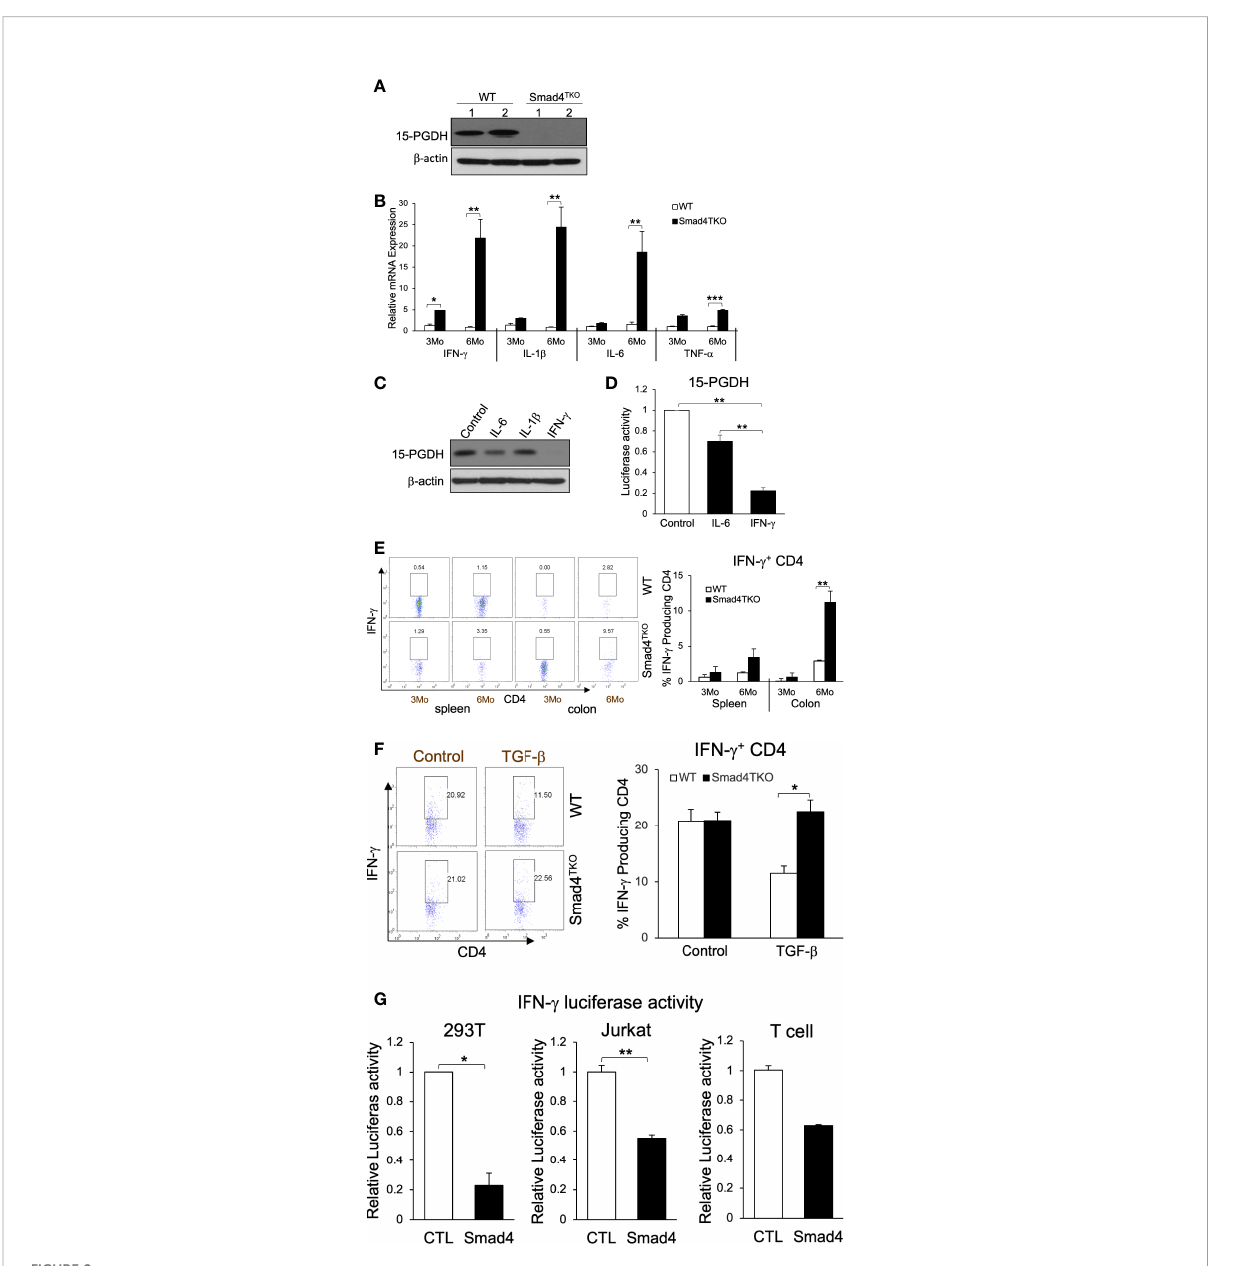
FIGURE 2 IFN- g down-regulates 15-PGDH expression in colon carcinoma cells and is inhibited by Smad4-dependent TGF- b signaling in T cells. (A) Protein expression of 15-PGDH was examined in the colon of WT and Smad4 TKO mice at 6 months of age by Western blot analysis. (B) Relative mRNA expression of pro-in fl ammatory cytokines (IFN- g , IL-1 b , IL-6 and TNF- a ) were measured by real time PCR in colon mucosa of WT and Smad4 TKO at 3 months and 6 months of age (n=4-6). (C) The effects of pro-in fl ammatory cytokines on 15-PGDH protein expressions in FET colon carcinoma cells. FET cells were treated with pro-in fl ammatory cytokines including IL-6 (20ng/ml), IL-1 b (5ng/ml) and IFN- g (20ng/ml) for 24 hrs and harvested for Western blot analysis to determine effects of these in fl ammatory cytokines on 15-PGDH protein expression. (D) 15- PGDH promoter activity in FET cells stimulated with IFN- g (20ng/ml) or IL-6 (20ng/ml) for 24 hrs was measured by using a dual luciferase assay. IFN- g suppressed 15-PGDH promoter luciferase activity. Results are representative of three different experiments. Bars, S.E. n=4, ** p < 0.01 compared with vehicle control group. (E) Analysis of effector CD4 + T cells expressing IFN- g of each genotype. Splenocytes and cells from colon lamina propria each genotype at 3 months and 6 months of age (n=5) were collected, stained on cell surface with antibody for CD4 and intracellularly with IFN- g antibody, and analyzed on CD4 + T cells by fl ow cytometry. (F) TGF- b suppression of IFN- g in WT CD4 T cells, not in Smad4 TKO CD4 T cells. CD4 T cells from Spleen each genotype at 2 months of age (n=3) were collected and incubated with anti-CD3/CD28 for 72 hours with or without TGF- b (2 ng/ml), intracellular stained with IFN- g and analyzed on CD4 T cells by fl ow cytometry. (G) Overexpression of Smad4 suppressed IFN- g promoter activity. Human IFN- g promoter was transfected in 293T, Jurkat and T cells and measured luciferase assay by dual luciferase assay. CD3 and CD28 were coated in the plate before plating T cells (n=3). Error bars indicate S.E.; * p < 0.05, ** p < 0.01 compared with control plasmid